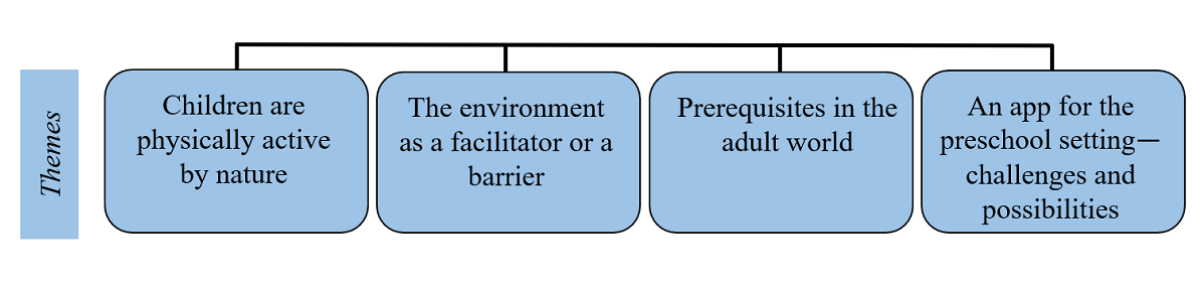
Figure 1. The themes identified in the thematic